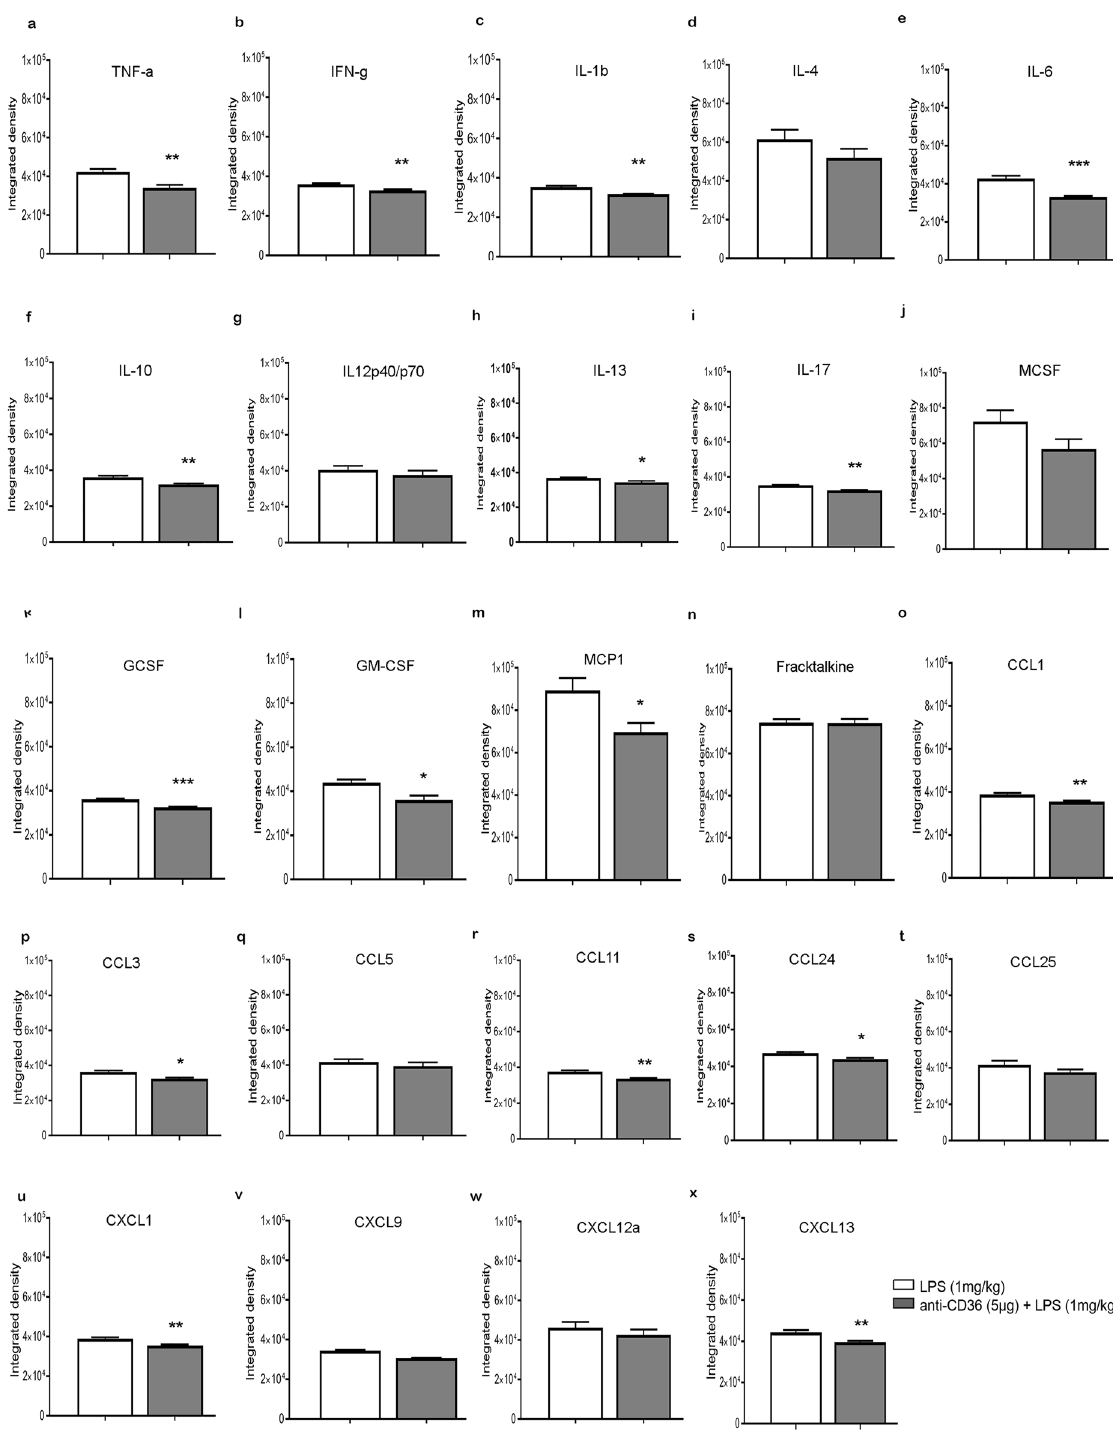
Figure 3. Treatment with anti-CD36 antibody reduces expression of inflammatory mediators after LPS challenge. ( a – x ) Protein expression of 24 inflammatory cytokines reveals a significant reduction in cytokines ( a ) TNF-a, ( b ) IFN-g, ( c ) IL-1b, ( e ) IL-6, ( f ) IL-10, ( h ) IL-13, ( i ) IL-17, along with ( k ) GCSF, ( l ) GM-CSF, ( m ) MCP-1 and chemokines ( p ) CCL3, ( r ) CCL11 ( s ) CCL24, ( u ) CXCL1, ( v ) CXCL9 and ( x ) CXCL13 when the pups are treated with anti-CD36 before LPS. Unpaired t-test ***p ≤ 0.001; **p ≤ 0.01 and *p ≤